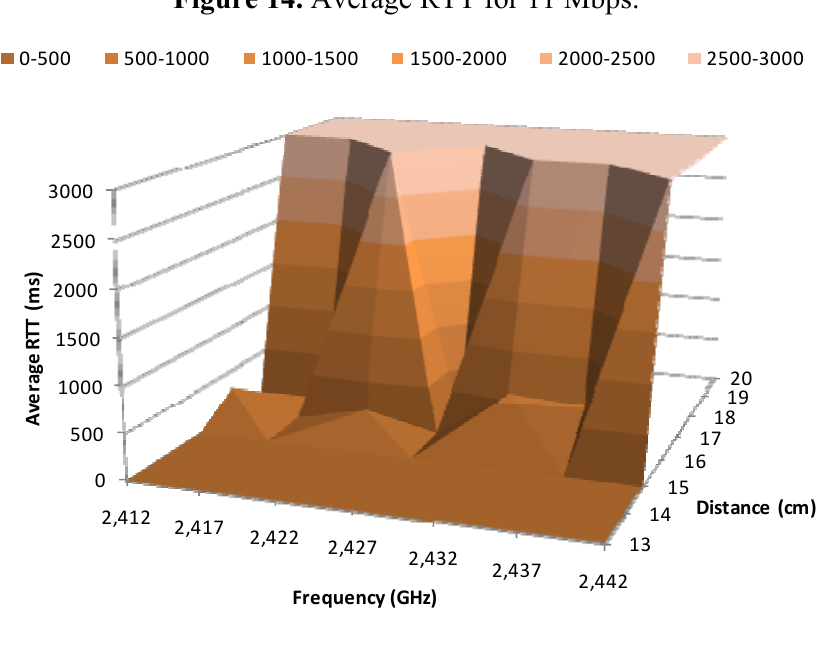
Figure 14. Average RTT for 11 Mbps.